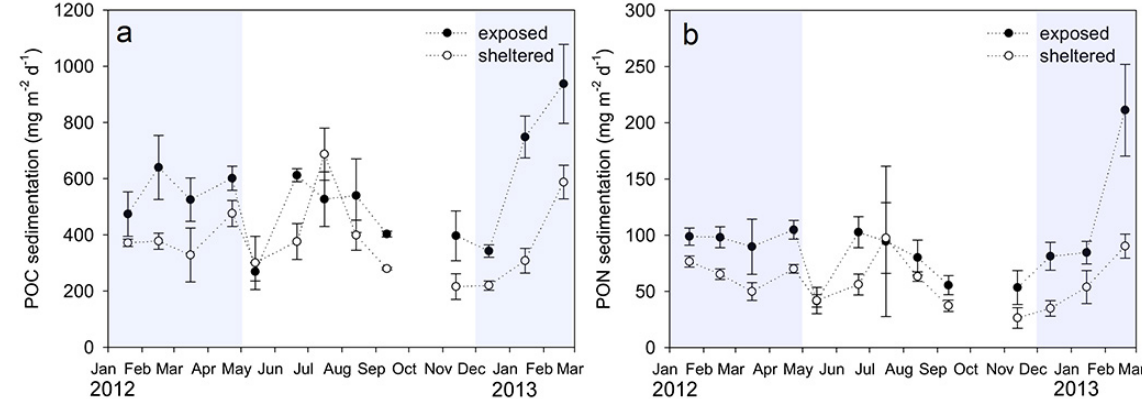
Figure 2. Sedimentary supply of POM to the seafloor. (a) Sedimentary POC; (b) sedimentary PON supply to the seafloor at an exposed and sheltered site in one exemplary bay in Tayrona National Natural Park (Gayraca). Upwelling periods are highlighted in blue. Abbreviations: particulate organic matter (POM), particulate organic carbon (POC), and particulate organic nitrogen (PON). Table 2. Correlation matrix of environmental sedimentary parameters with distance to Santa Marta and seasonal resolution. Significance levels of correlation coefficients (Spearman’s rank correlation) among environmental variables with distance to Santa Marta are indicated by asterisks with ∗ for significant ( p < 0.05). Not significant values are displayed in italics. Abbreviations as previously defined in Table 1 and sediment oxygen demand (SOD). Seasons Correlations with distance to Santa Marta Chl a POC PON SOD CaCO 3 Porosity Grain size Major upwelling 0.76